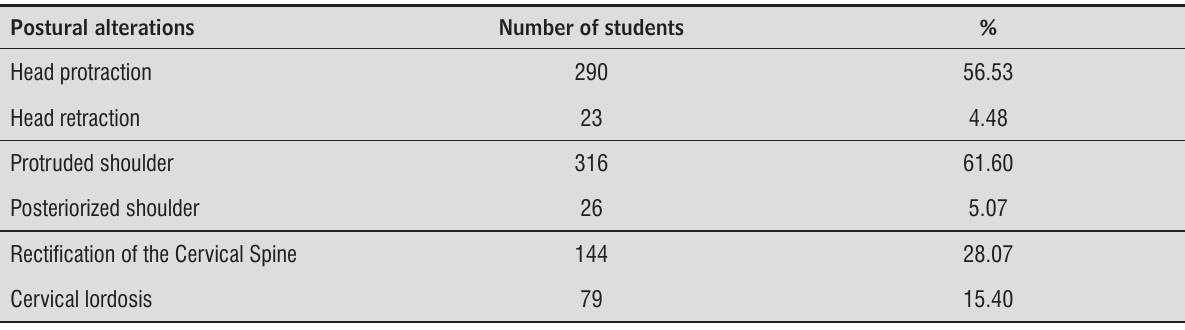
Table 3 - Alterations in the positioning of the head, shoulders, neck, cervical and thoracic spines, pelvis, knees and feet in the side